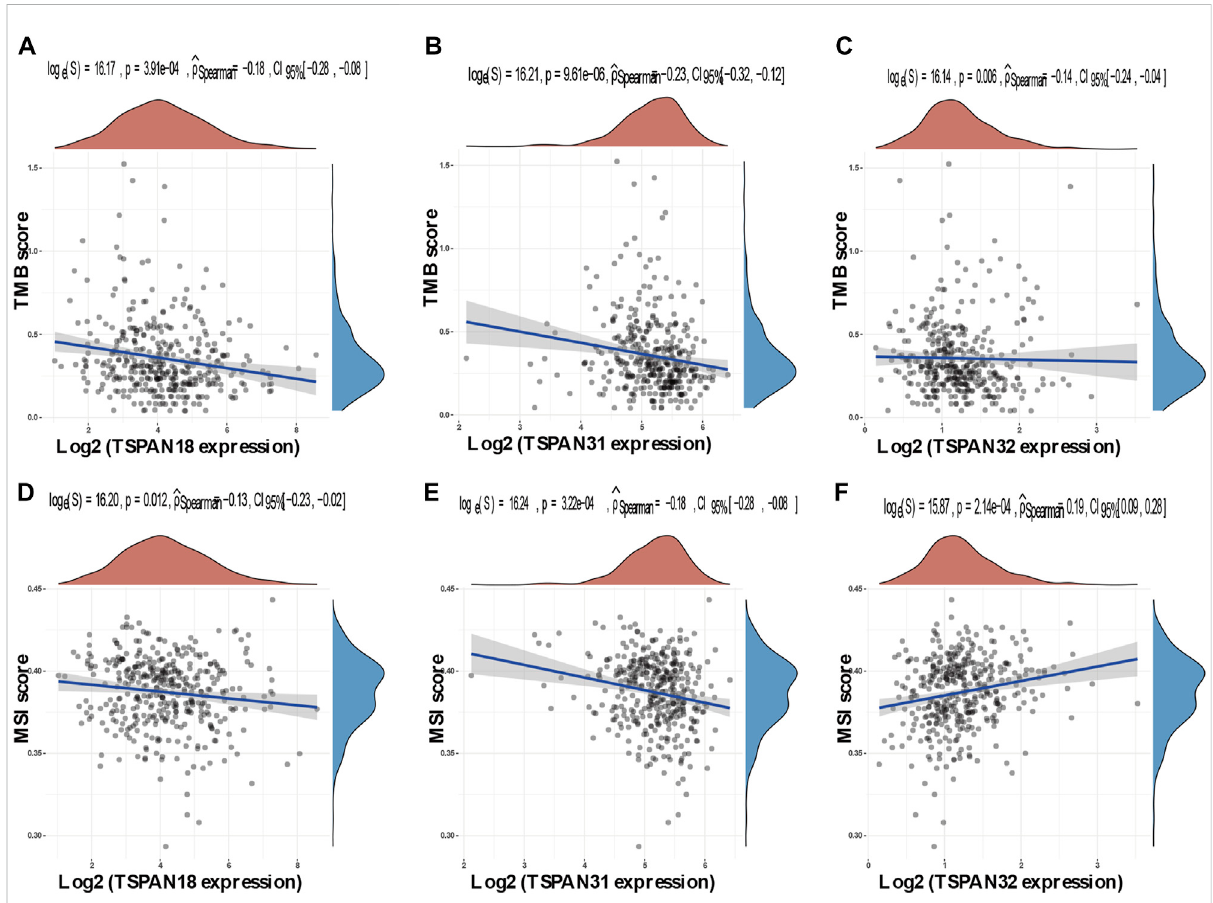
FIGURE 10 Correlation between TM4SFs and TMB/MSI in PTC patients. (A – C) A stick chart shows the relationship between the TM4SFs gene expression and TMB in diverse tumors. The red curve represents the correlation coef fi cient, and the blue value represents the range; (D – F) A stick chart shows the association between the TM4SFs gene expression and MSI in diverse tumors. Correlation analysis was performed using Spearman ’ s method.